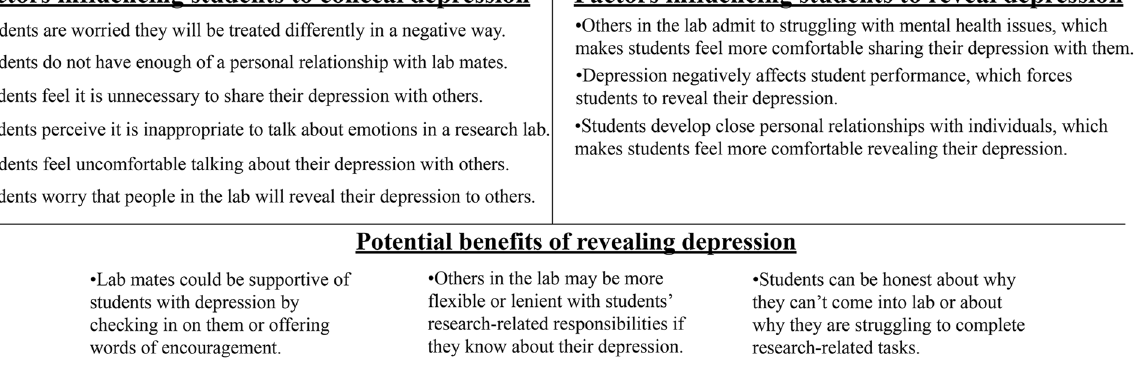
Fig. 1 Summary of factors that influence students to conceal and reveal their depression, and the benefits of revealing